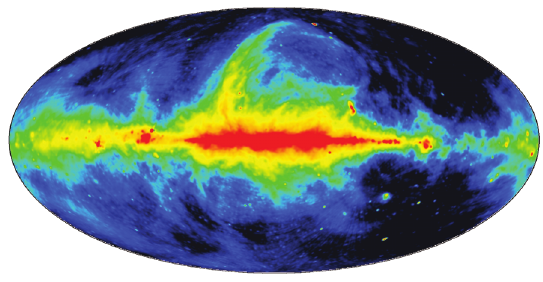
Figure 3. All-sky map in Galactic coordinates (with the Galac- tic center in the middle) of the total intensity of the 408MHz radio continuum emission (presumably pure synchrotron emis- sion) from the Bonn 408MHz All-Sky Survey, using data ob- tained with the Jodrell-Bank 76m, E ff elsberg 100m and Parkes 64m radio telescopes. Figure credit: MPIfR / Patricia